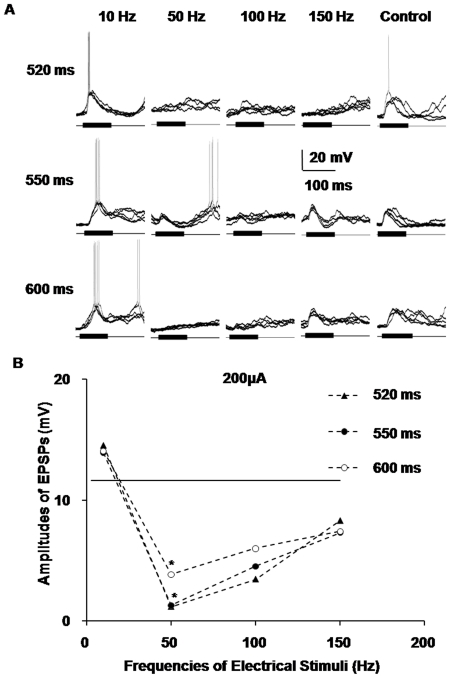
Different responses of AI neurons at varied frequencies and intervals of train stimuli.
A) Five superimposed traces of the sound-evoked responses in AI neurons after train stimulation of the MGBv at incremental frequencies of electrical stimulation and intervals between the paired stimuli. B) The statistical broken line chart of the average amplitudes of the EPSPs in (A). When the stimulus intervals were shorter than 700 ms, the changing tendencies of the different groups of varied stimulus intervals were approximately the same. They all exhibited consistent effects. The amplitudes of the sound-evoked EPSPs of AI neurons increased to higher than those of the control group when the train stimulus frequency of the MGBv was 10 Hz. When the frequencies of the electrical stimuli increased to high levels, including 50 Hz, 100 Hz and 150 Hz, the amplitudes of the EPSPs all decreased to lower than those of the control group. In particular, when the frequency was 50 Hz, the amplitudes of the EPSPs were significantly lower than those of the control group, and might even be close to zero. (*P<0.05).